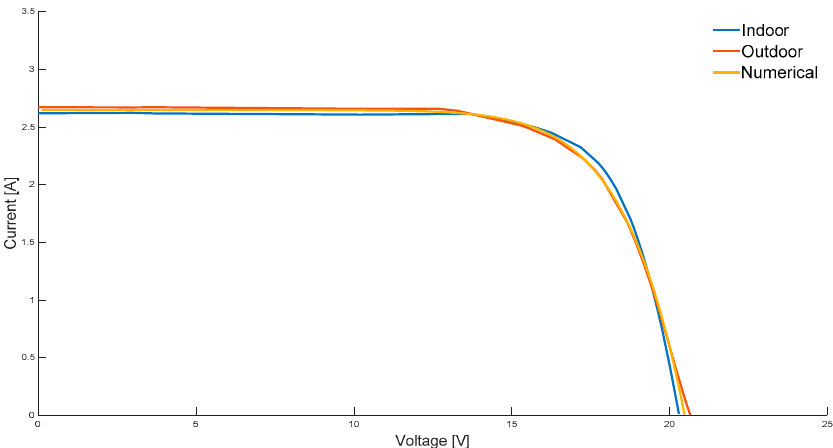
Figure 12. Comparison of indoor, outdoor, and numerical I–V curve.